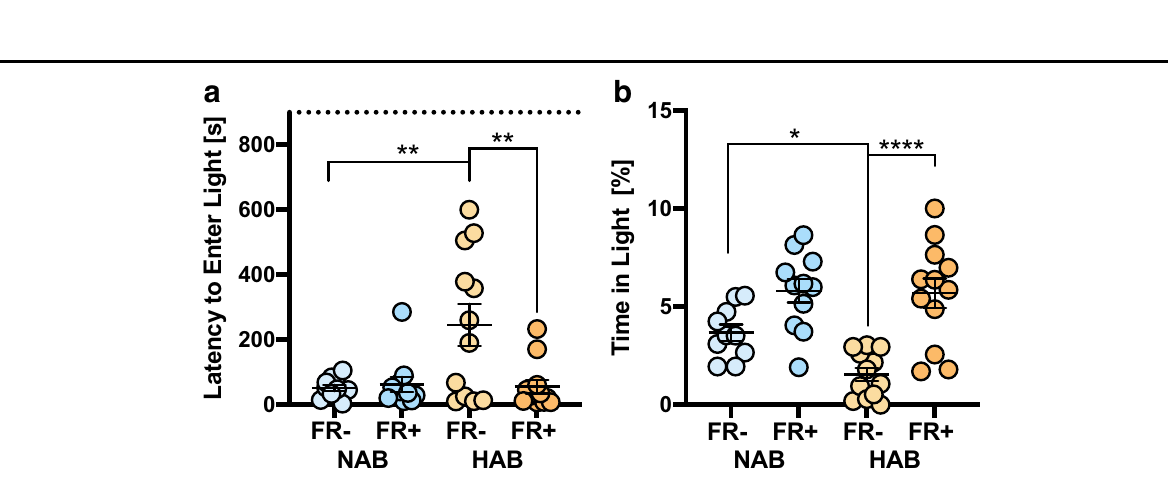
Fig. 3 Dark – light transition task (DaLi). a , b Behavioral performance of food-restricted (FR + ) and ad libitum-fed (FR − ) HAB and NAB mice during a 15-min exposure to the DaLi setup. For further details see Fig.